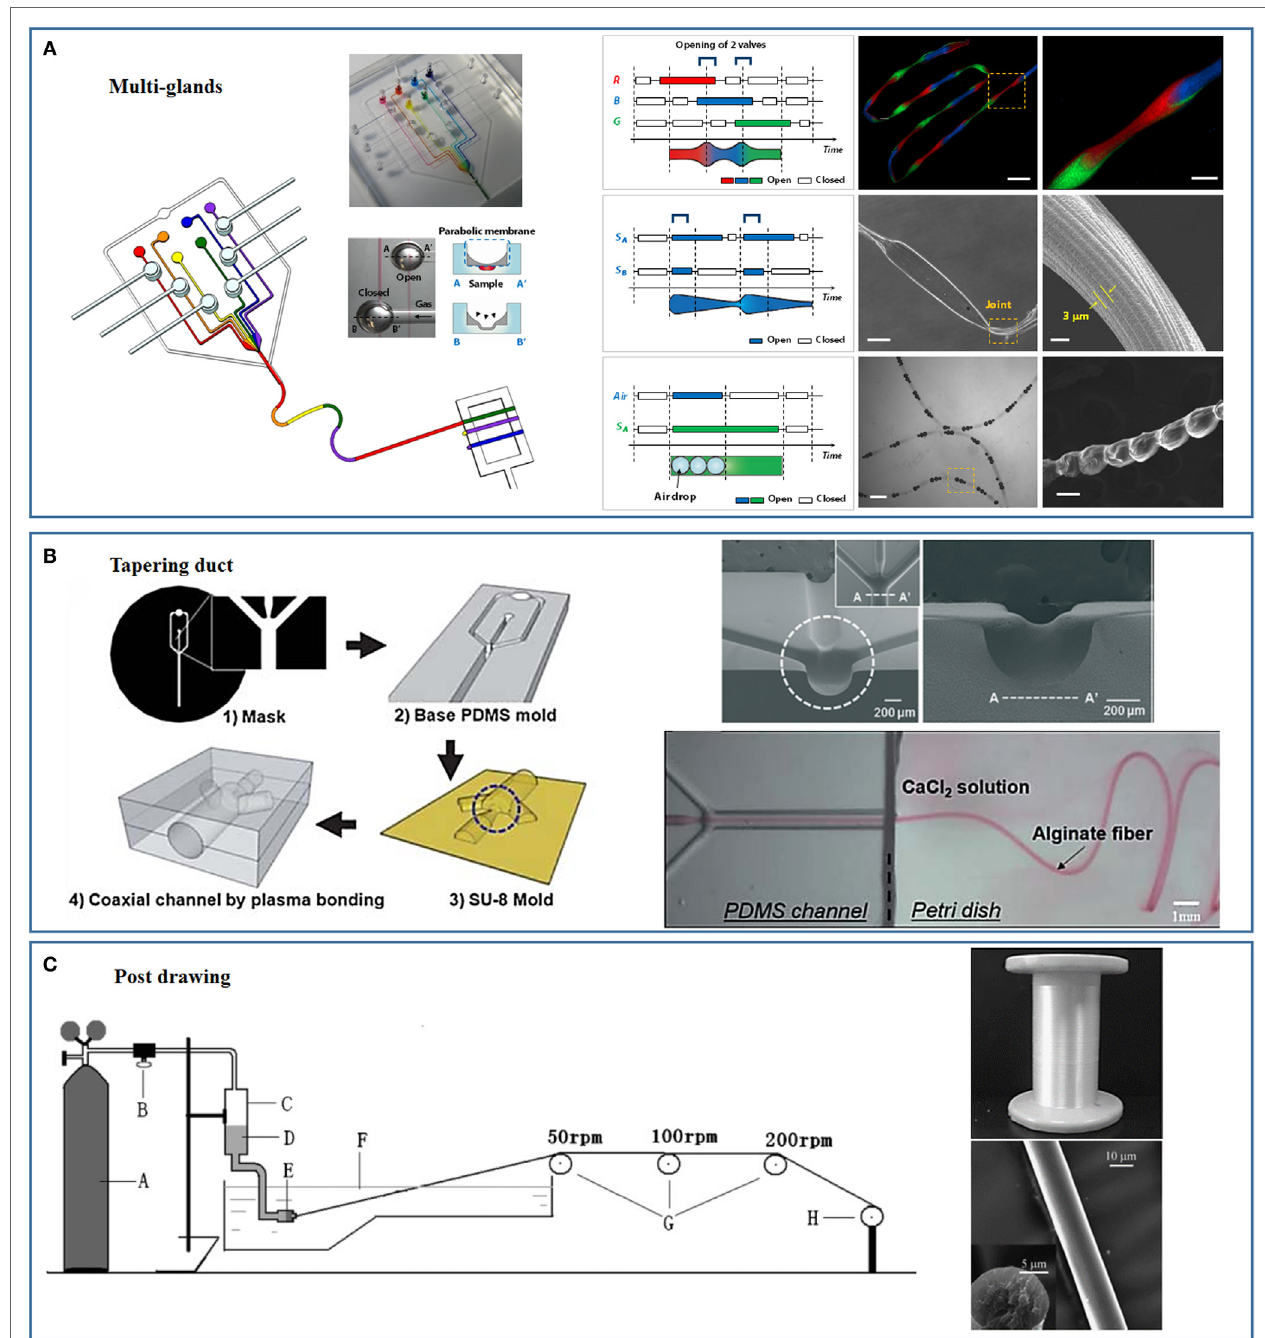
FiGURe 3 | Novel spinning processes and microplatforms inspired by nature. (A) Multi-glands mimicking microfluidic chip and the as-spun hierarchical artificial microfibers [reprinted with permission from Kang et al. (2011). Copyright 2011 Nature Publishing Group]. (B) Tapering duct mimicking microfluidic chip [reprinted with permission from Kang et al. (2010). Copyright 2010 Royal Society of Chemistry; reprinted with permission from Jun et al. (2013). Copyright 2013 Elsevier]. (C) Strong fibers prepared through mimicking the post-drawing process of natural spinning [reprinted with permission from Zhou et al. (2009). Copyright 2009 John Wiley and